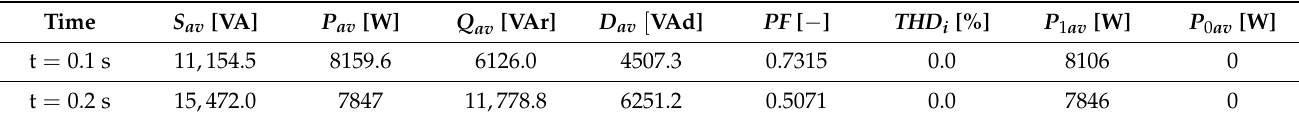
Table 32. Simulation results before and after the change (at steady states).